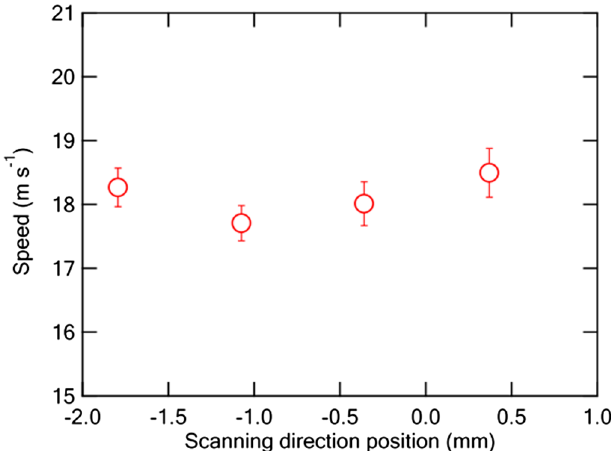
FIG. 9 (color online). Wire speed variation along the scanning direction determined from 5 profiles obtained with 25 kHz laser modulation. The scanning speed was calculated by measuring the distance between adjacent wire images, at the location where the wire intersects the center of the beam